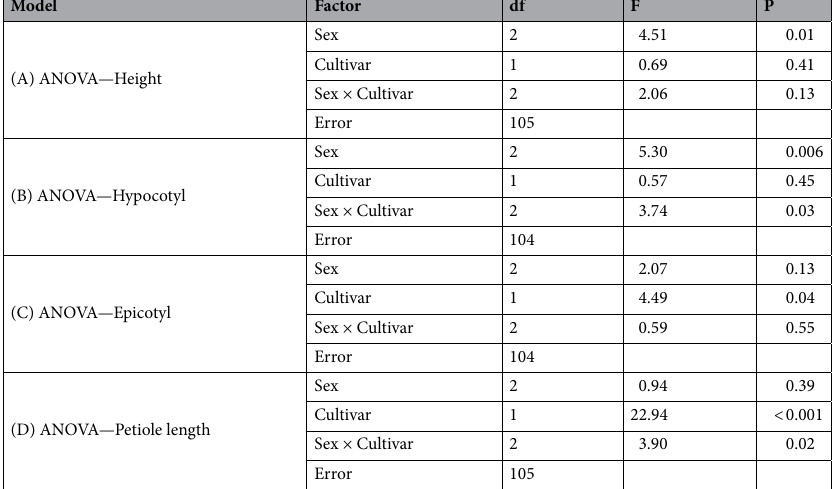
Table 2. Preliminary analysis comparing the physical differences in three traits between co-sexual, male and female plants in a multivariate analysis of variance (MANOVA) of two cultivars (CFX-1, CFX-2) of hemp. Analysis of variance (ANOVA) was used to compare combinations of experimental factors (sex, cultivar and their combination). Response variables (four phenotypic traits: height, hypocotyl length, epicotyl length, petiole length) were natural log transformed. F-value is the test statistic used, p-value is the related probability of the null hypothesis being true based on the analysed observations, and df is the associated degrees of freedom.